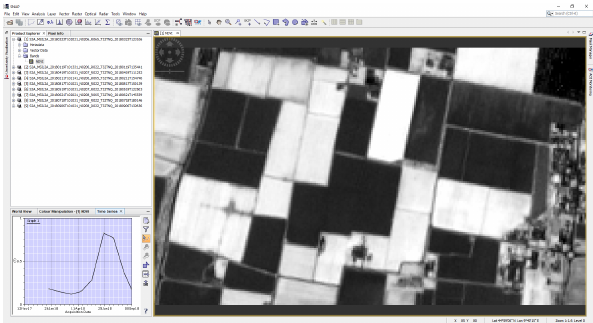
Figure 8. NDVI evolution using the Time series